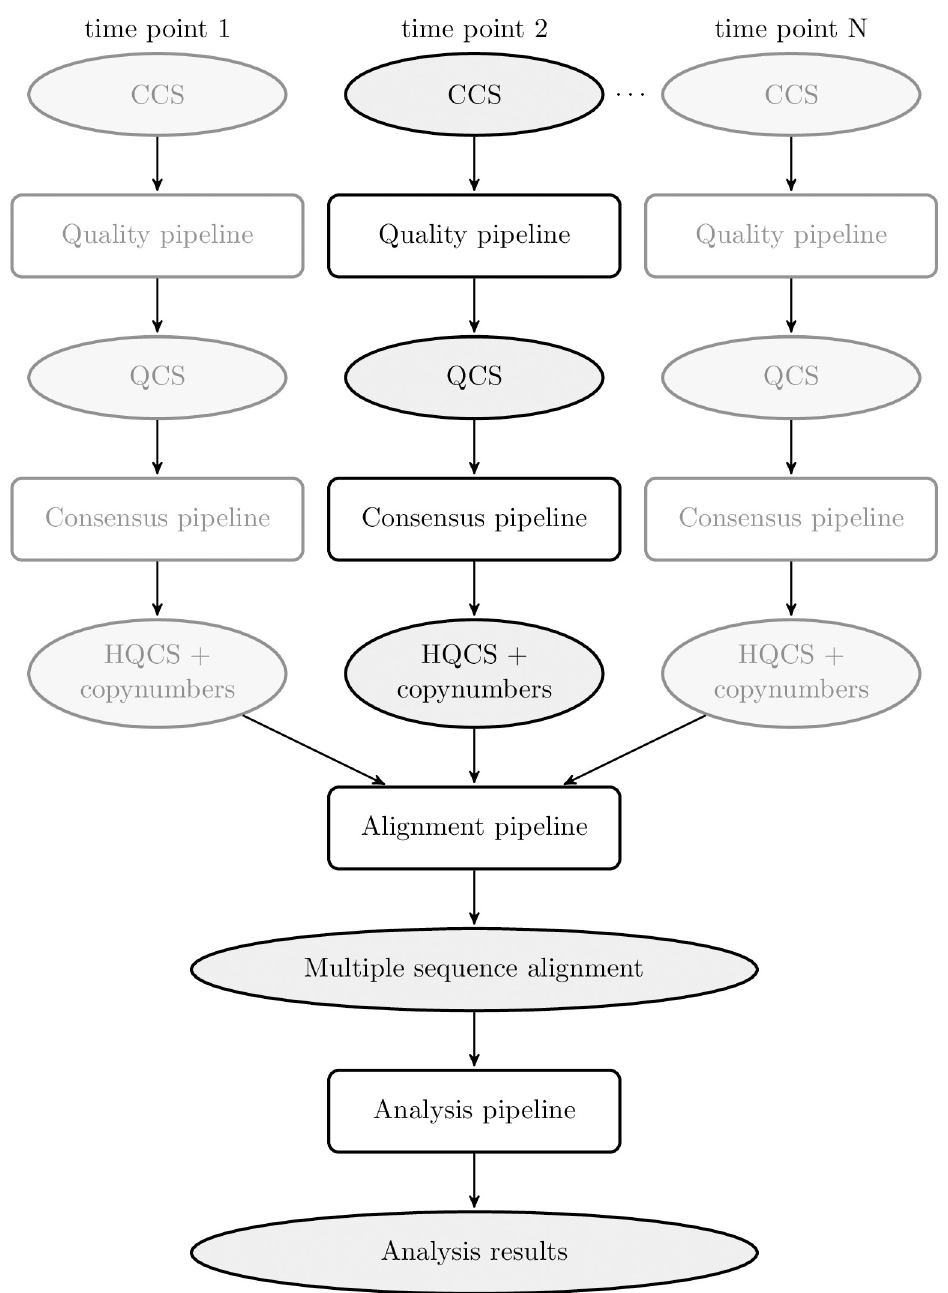
Fig 1. Overview of the FLEA pipeline, broken into conceptual sub-pipelines. The Quality and Consensus sub- pipelines process each time point separately. Duplicate steps in other time points are grayed out. CCS stands for “circular consensus sequences”; QCS for “quality-controlled sequences”, and HQCS for “high-quality consensus